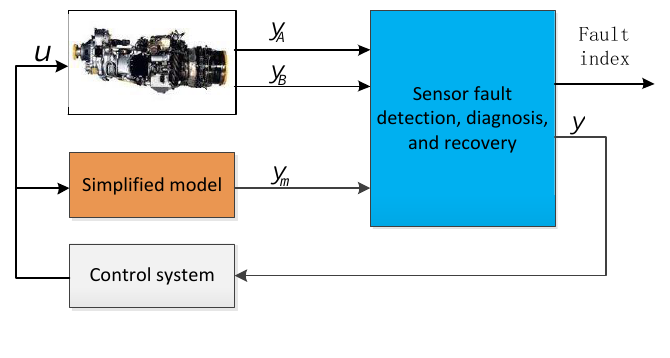
Figure 3. Sensor fault detection, diagnosis, and recovery